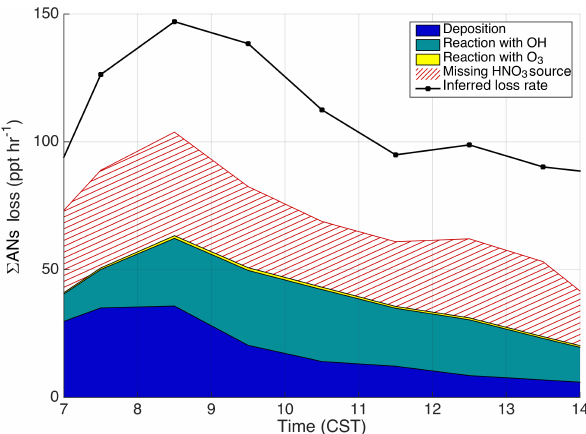
Figure 7. Loss rates and fates of (cid:54) ANs during SOAS. The black line shows the loss rate of (cid:54) ANs based on the difference between the calculated production rate and the observed change in concen- tration. The shaded areas show the rates of known (cid:54) ANs loss pro- cesses, and the hatched area shows the missing nitric acid